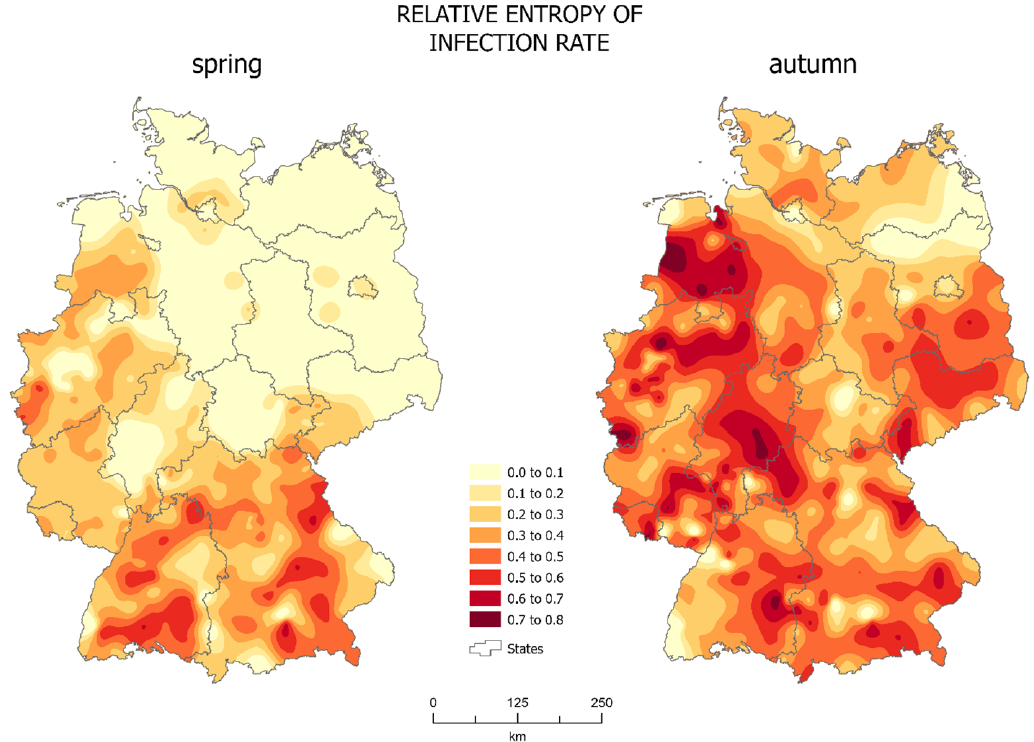
Figure 3. Relative entropy (source: own work).